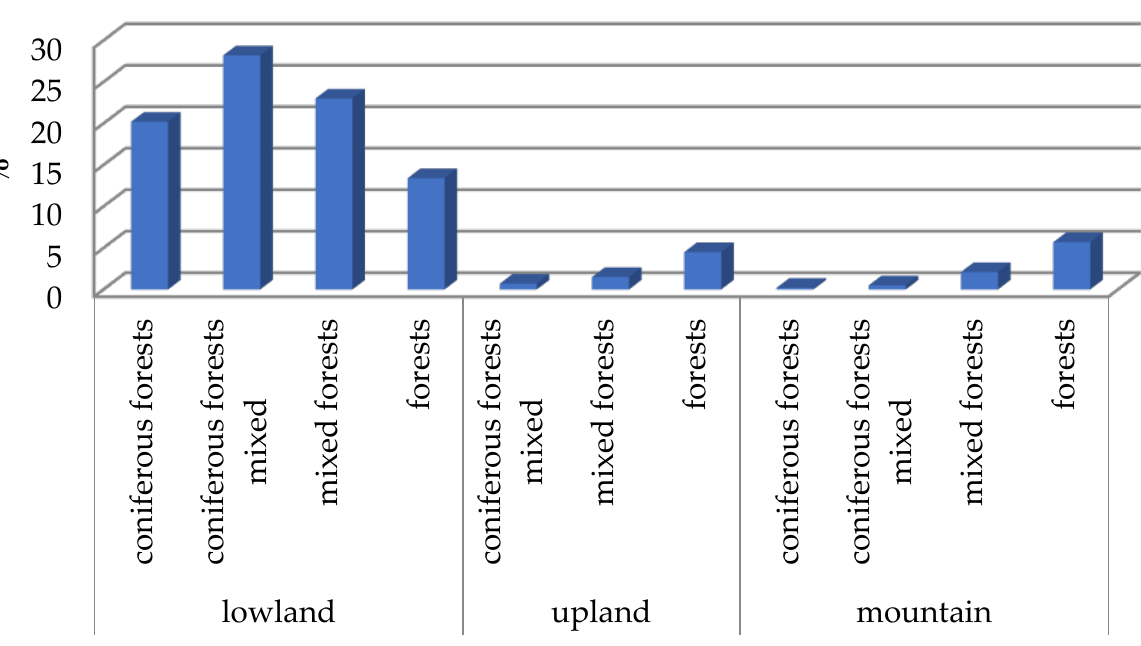
Figure 1. The percentage of individual types of forest in the research area (Statistical Yearbook of Forestry 2021 [30,31]).